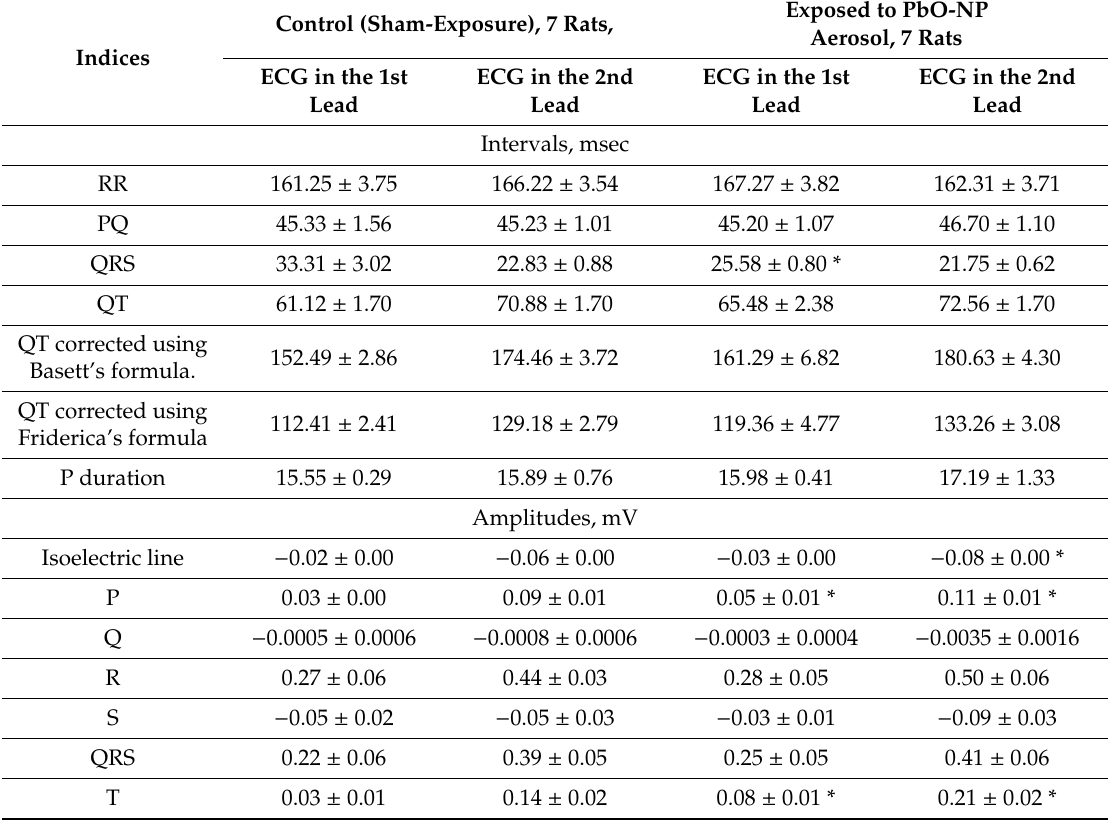
Table 5. Electrocardiogram (ECG) readings in rats after repeated inhalation of lead oxide nanoparticles (x ± s.e.).